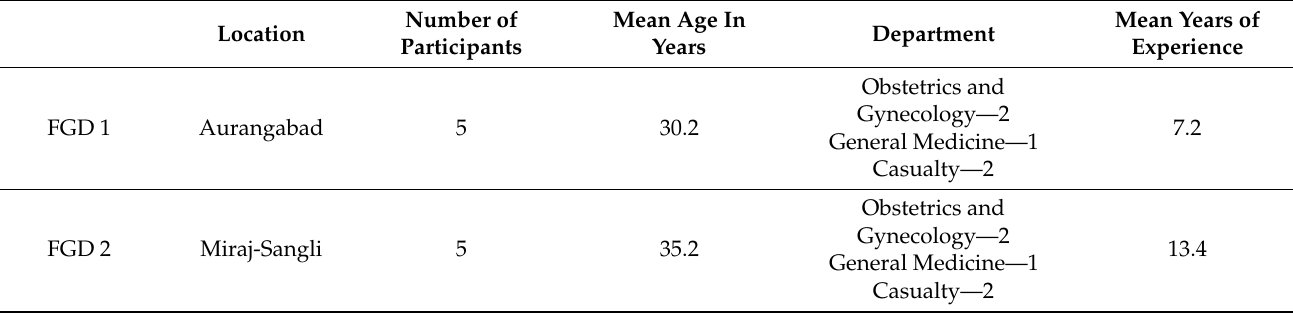
Table 2. Profile of participants of focus group